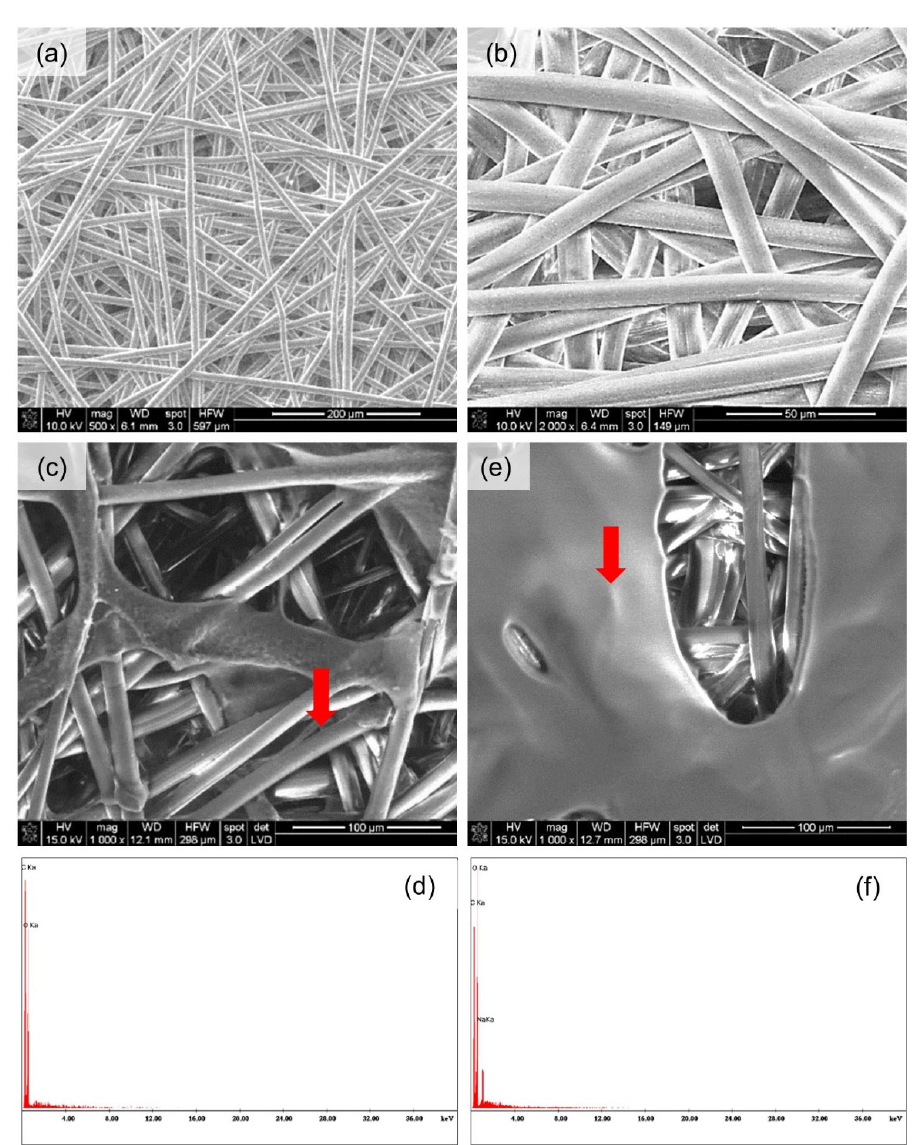
Figure 14. SEM and EDX images of the spun ‐ bonded PLA nonwoven fabrics: ( a , b ) reference sam ‐ ple—spun ‐ bonded PLA nonwoven without deposit; ( c , d ) sample with sodium alginate deposition (3 min, 35 V, T = 25 °C); ( e , f ) sample with sodium hyaluronate deposition (3 min, 35 V, T = 25 °C). 35 V, T = 25 ◦ C); ( e , f ) sample with sodium hyaluronate deposition (3 min, 35 V, T = 25 ◦